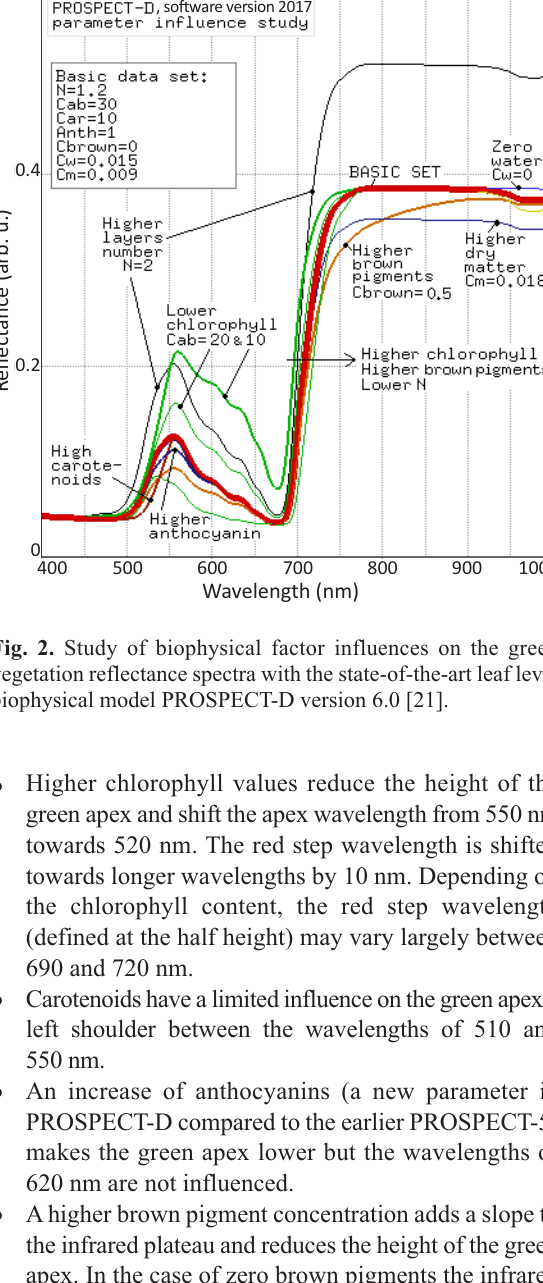
● The rather poorly defined parameter of leaf structure, i.e. the number of air–cell walls N , has a very strong influence. The effect of higher N is similar to reduced chlorophyll concentration. The green apex peak near 550 nm increases almost proportionally to N and the red step is shifted towards lower wavelengths by 10– 20 nm. The increase of the infrared plateau height at wavelengths over 770 nm is also noticeable but smaller than the increase of the green apex peak.